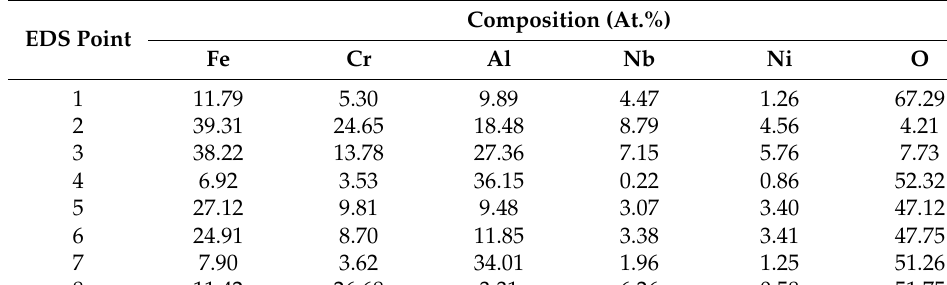
Table 3. EDS results at each point marked in Figure 6 (At.%).